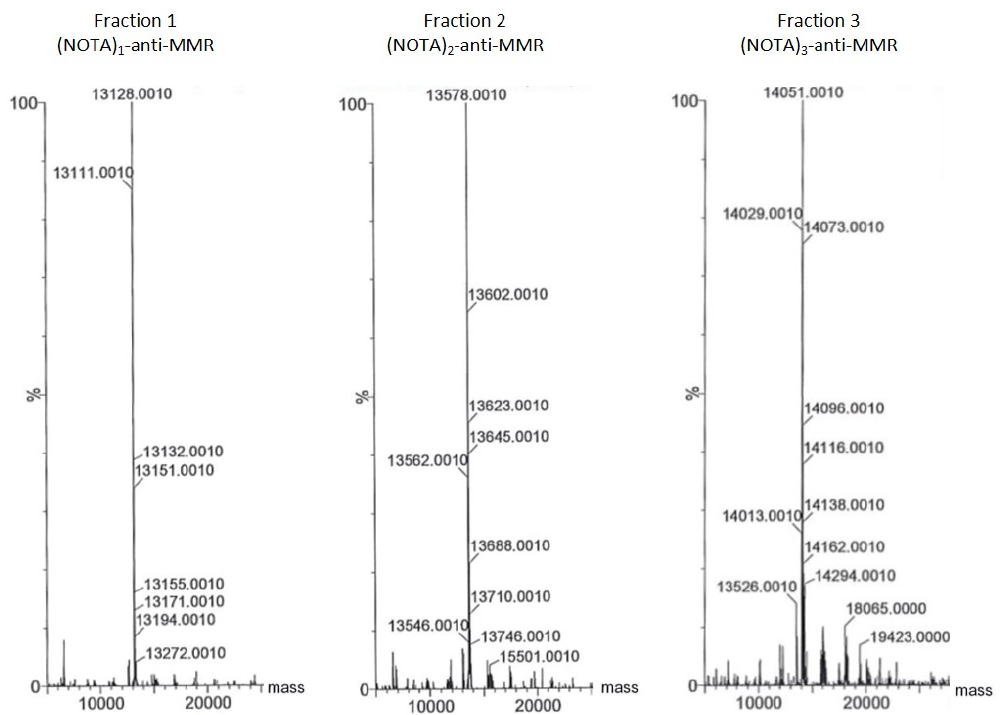
Figure 2. Mass spectrometry spectra of (NOTA)1-anti-MMR (fraction 1), (NOTA)2-anti-MMR (fraction 2), and (NOTA)3-anti-MMR (fraction 3). Theoretical molecular weights were calculated at 13,128.6, 13,579.1, and 14,029.6, respectively. Mass measurement error is 1 Da.